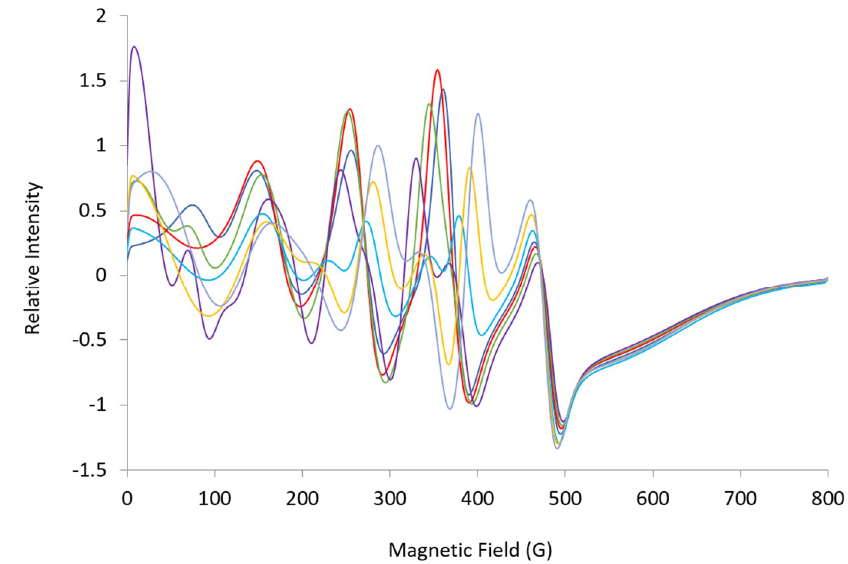
Figure 8. Simulated L-band (1.37 GHz) spectra: A = [369, 508, 100], g eff = [4.96, 4.55, 1.94], HStrain = [150, 150, 600] (blue); A -low field = 350 MHz (red), 330 MHz (green), 300 MHz (purple), 400 MHz (light blue), 420 MHz (orange), 440 MHz (light purple). Changes in A -low field affect lines throughout the L-band spectra expected for the high field line.